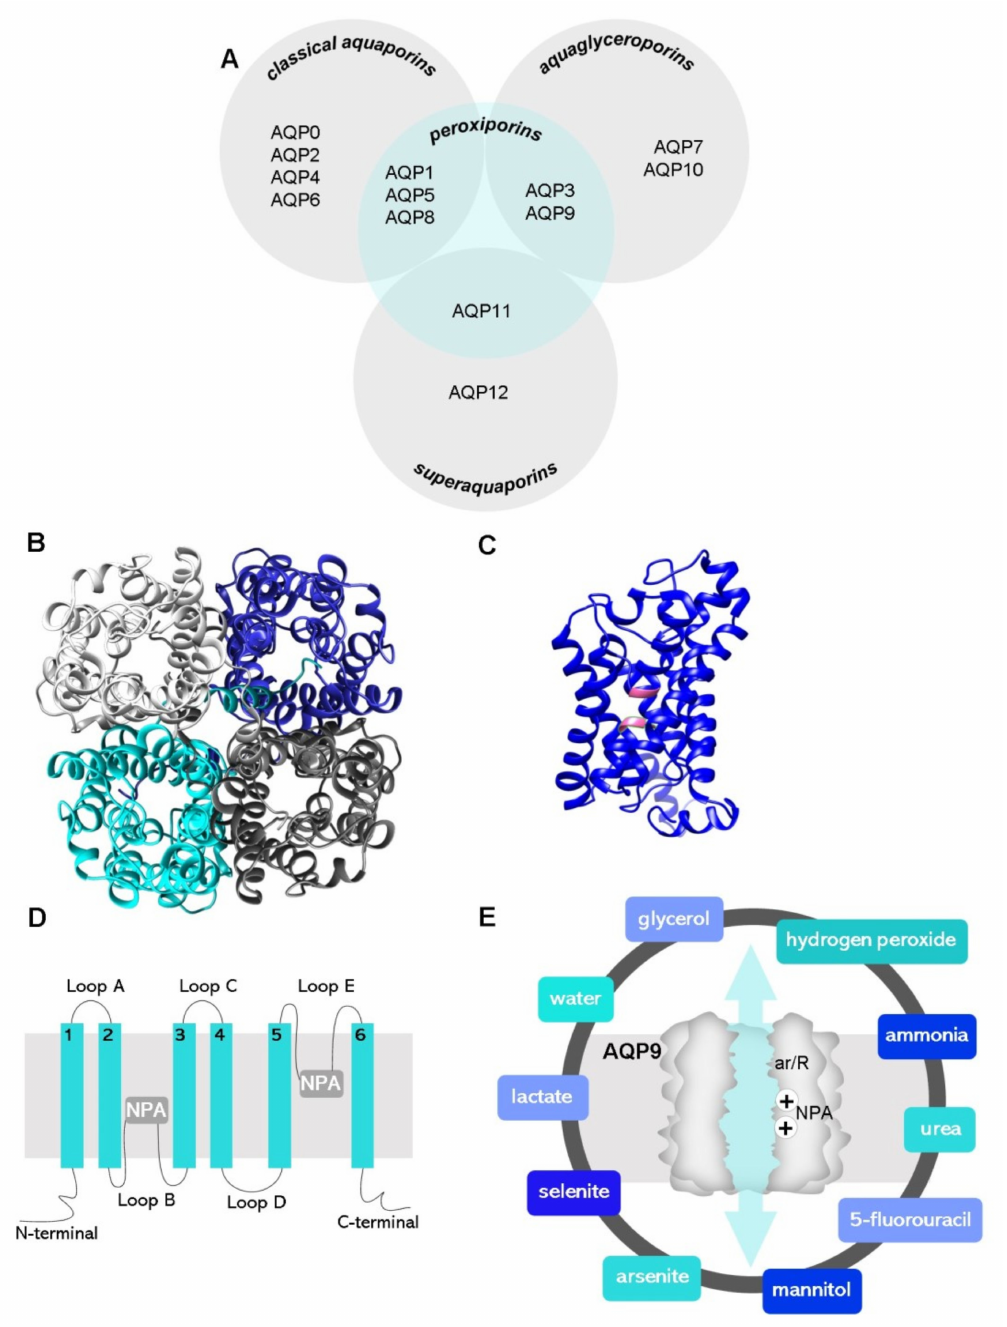
Figure 1. ( A ) General distribution of the 13 AQP paralogs according to their primary structure (grey circles) and selectivity. ( B ) Top view of the homotetrameric representation of the AQP9 glycerol channel and ( C ) side monomer view with the two NPA motifs (pink colored) based on a predictive structure generated in Phyre2 web portal. Final figures were generated using UCSF Chimera software. ( D ) Representation of AQP membrane topography, showing the monomer comprising six membrane- spanning α -helices (1–6) connected by five loops (A–E), the conserved asparagine–proline–alanine (NPA) motifs embed in the membrane. In the functional monomer, the hydrophilic loops B and E are bent back into the cavity formed by the two half-helixes. The two loops are spatially close to form the charge selective gate containing the two NPA motifs. ( E ) Graphical illustration of an AQP9 channel displaying the two selectivity filters: size and charge, ar/R and NPA, respectively, represented, and the molecules known to permeate the AQP9